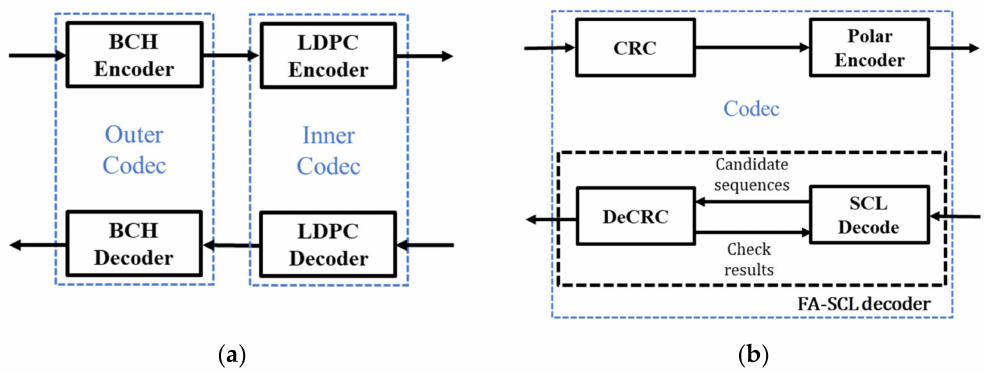
Figure 12. Forward Error Correction encoder and decoder for: ( a ) Original DVB systems.; ( b ) Proposed DVB systems.